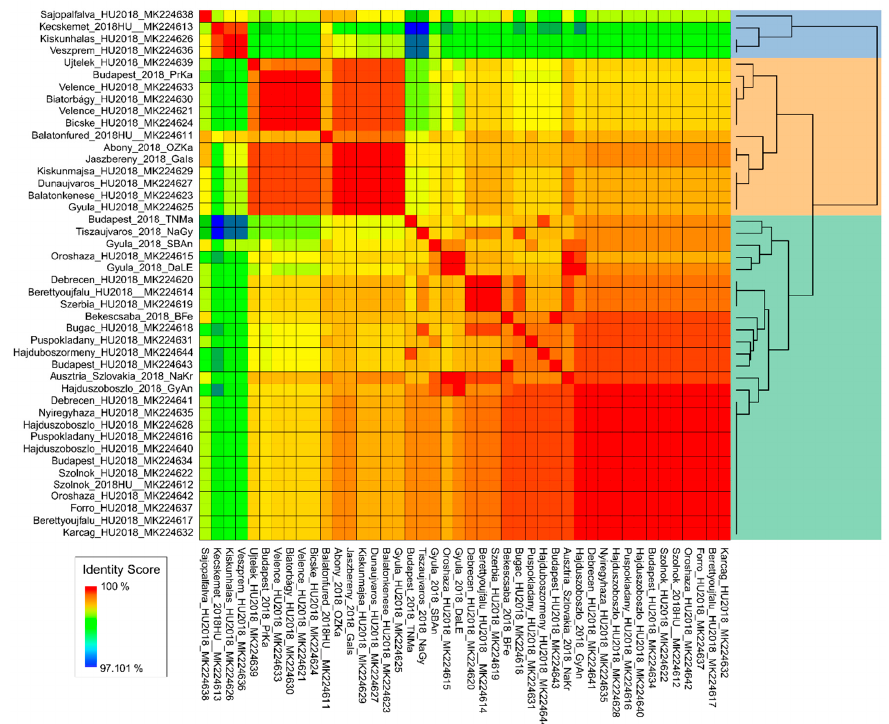
Figure 5. Human-derived, partial WNV NS3 sequences from the 2018 season. The figure represents similarity scores of all available human-derived WNV partial NS3 sequences from 2018. The two dominant genetic subclades are highlighted on the dendrogram with green and peach color. Viruses 2020 , 11 , x FOR PEER REVIEW